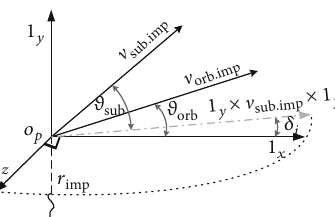
Figure 3: The velocity vector relations of orbits at the point P